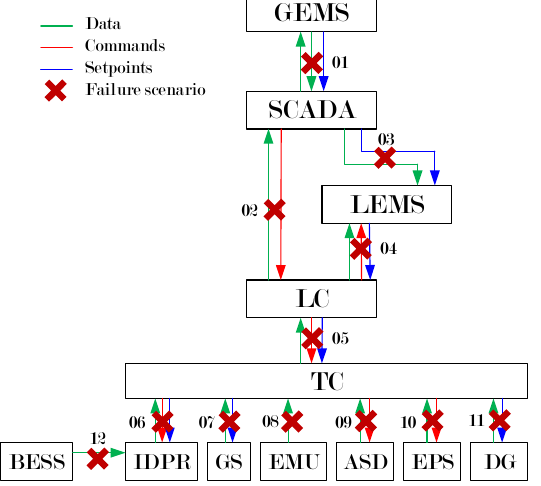
Figure 7. Failure communications